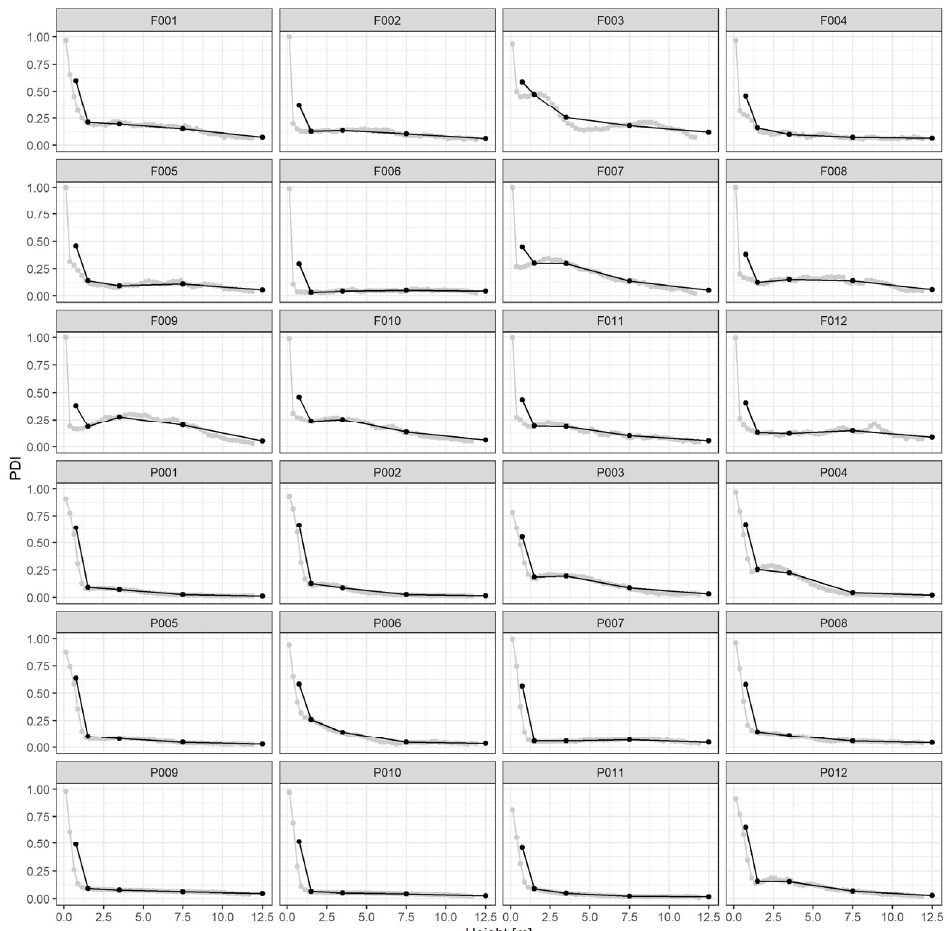
Figure 4. Vertical profiles of the Plant Vegetation Index (PDI), by plot, for all 24 stands. Grey dots are voxel high (0.5 m) slices averages. Black dots refer to PDI average values by height class, from left to right, they represent: FF—forest floor, Sh—shrubs, LU—lower understory, UU—upper understory, Sc—subcanopy.